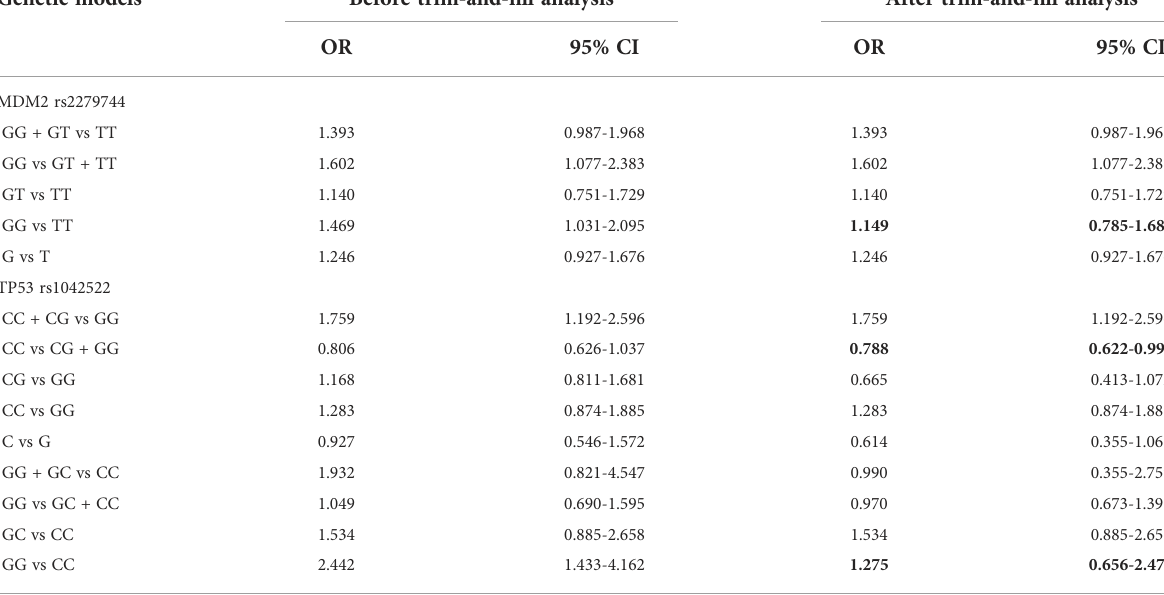
TABLE 6 Comparison of pooled effects before and after trim-and- fi ll analysis. Genetic models Before trim-and- fi ll analysis After trim-and- fi ll